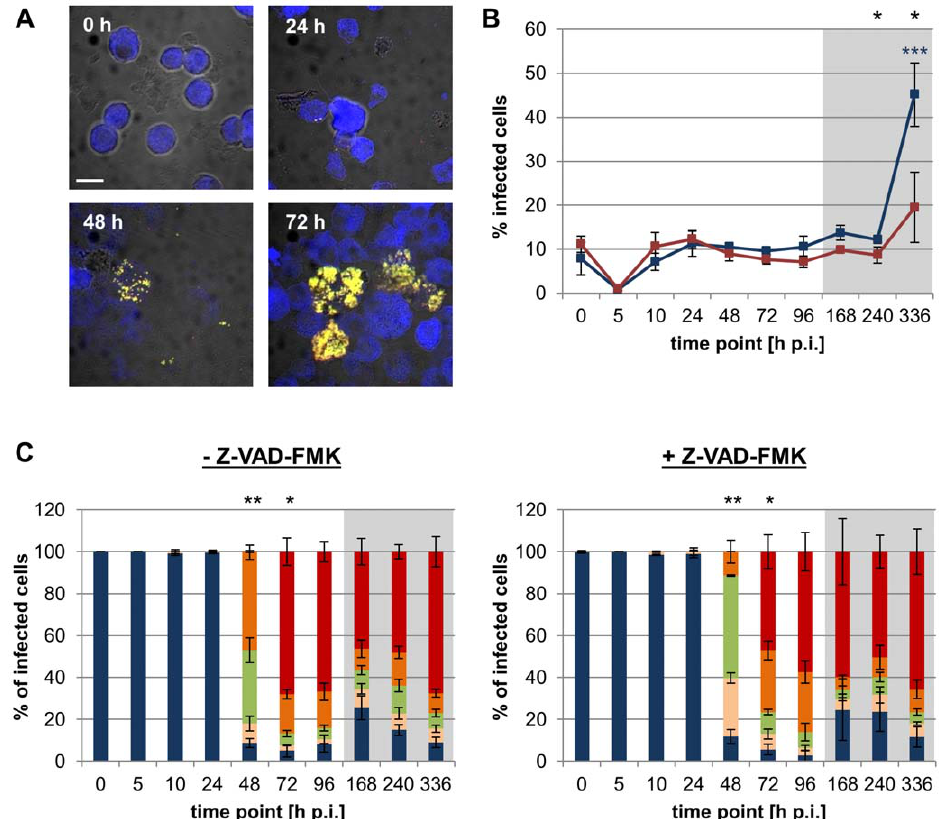
Figure 6. Effect of caspase inhibition on the infection of S2 cells with S.negevensis . S2 cells were infected with S. negevensis (MOI 5) and were incubated for the indicated time periods in the absence or presence of the pan caspase inhibitor Z-VAD-FMK (10 m M). Bacteria were detected with the FISH probes Simneg183 (Fluos, green) and Chls-0523 (Cy3, red), host cells with the probe EUK516 (Cy5, blue). Representative confocal images of the infection cycle (in the absence of Z-VAD-FMK) are shown in (A). The bar indicates 10 m m. The percentage of infected cells observed in the absence (blue) or presence (red) of Z-VAD-FMK over the course of infection is depicted in (B). Black stars indicate statistically significant differences between both curves (t-test) and colored stars indicate significant differences to the respective 0 h p.i. time point (ANOVA & Scheffe´). Numbers of intracellular bacteria per infected cell were determined and are shown in (C). Infected cells were classified into 5 groups according to the number of intracellular bacteria (1–3, blue; 4–10, rose; 11–30, green; 31–100, orange; . 100, red). Stars indicate statistically different distributions among these classes at a given time point between infections that occurred in the absence or presence of Z-VAD-FMK ( x 2 test). In (B) and (C) mean values and standard deviations of three replicates are shown (***, p # 0.001; **, p # 0.01; *, p # 0.05). The gray boxes indicate time points that were analyzed after cells had been passaged.